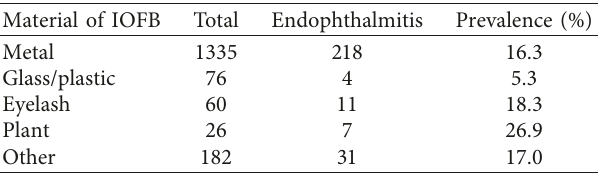
Table 2: The prevalence of endophthalmitis in different IOFB material